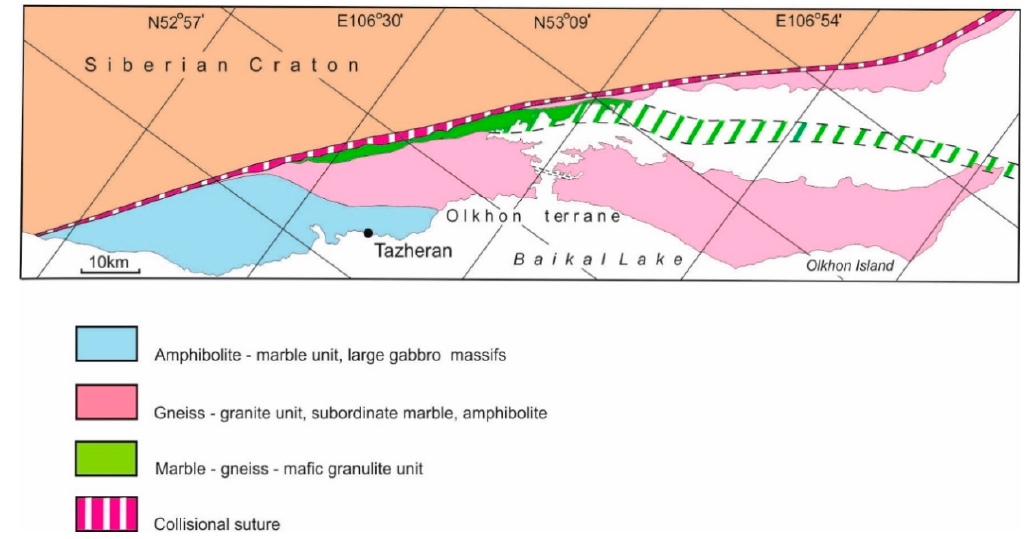
Figure 2. Simplified tectonics of the Olkhon terrane, modified after [16]: Tazheran Massif is shown as a black circle.